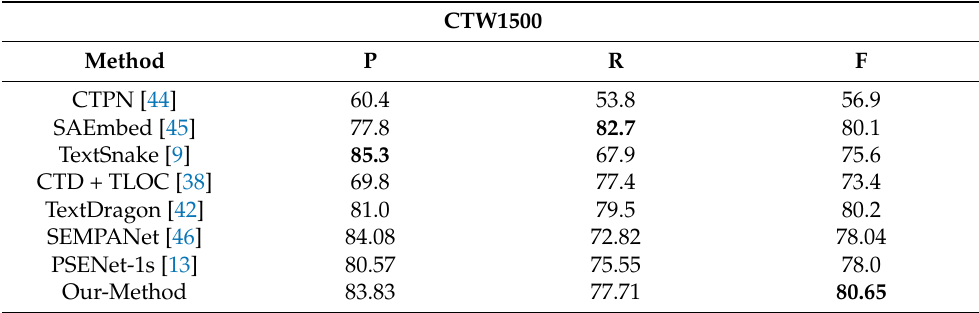
Table 3. The single-scale results on CTW1500. “P”, “R”, and “F” represent the precision, recall, and F-measure, respectively. The best results of all measures are